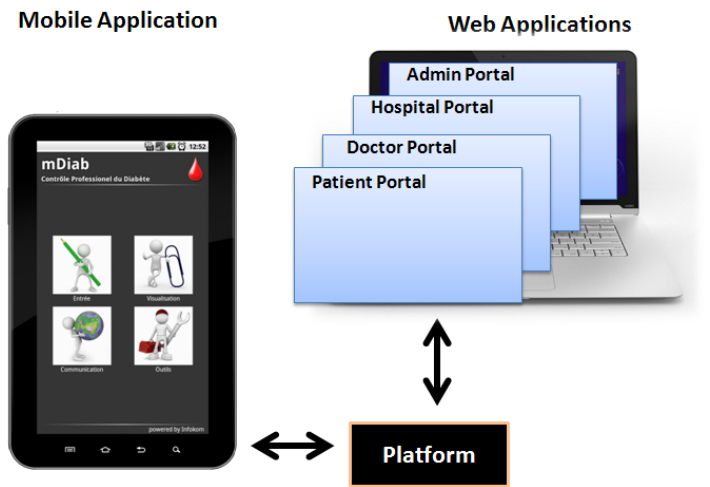
Figure 1. ―Mobil Diab‖ System